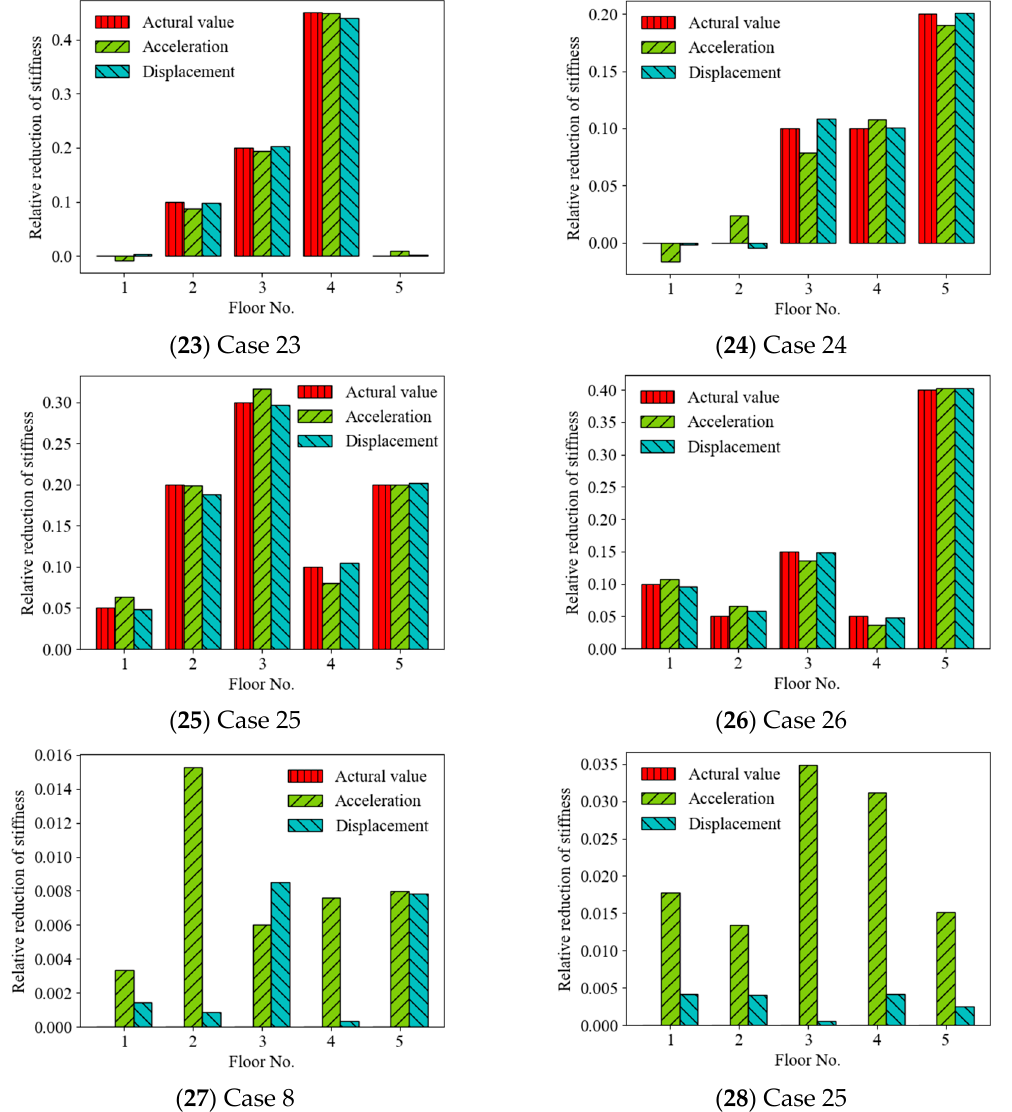
Figure 4. Prediction results of structural anomaly using displacement and acceleration responses as ANN input. (( 1 – 26 ) Mean values of relative stiffness reduction; ( 27 , 28 ) standard deviations of relative stiffness reduction.